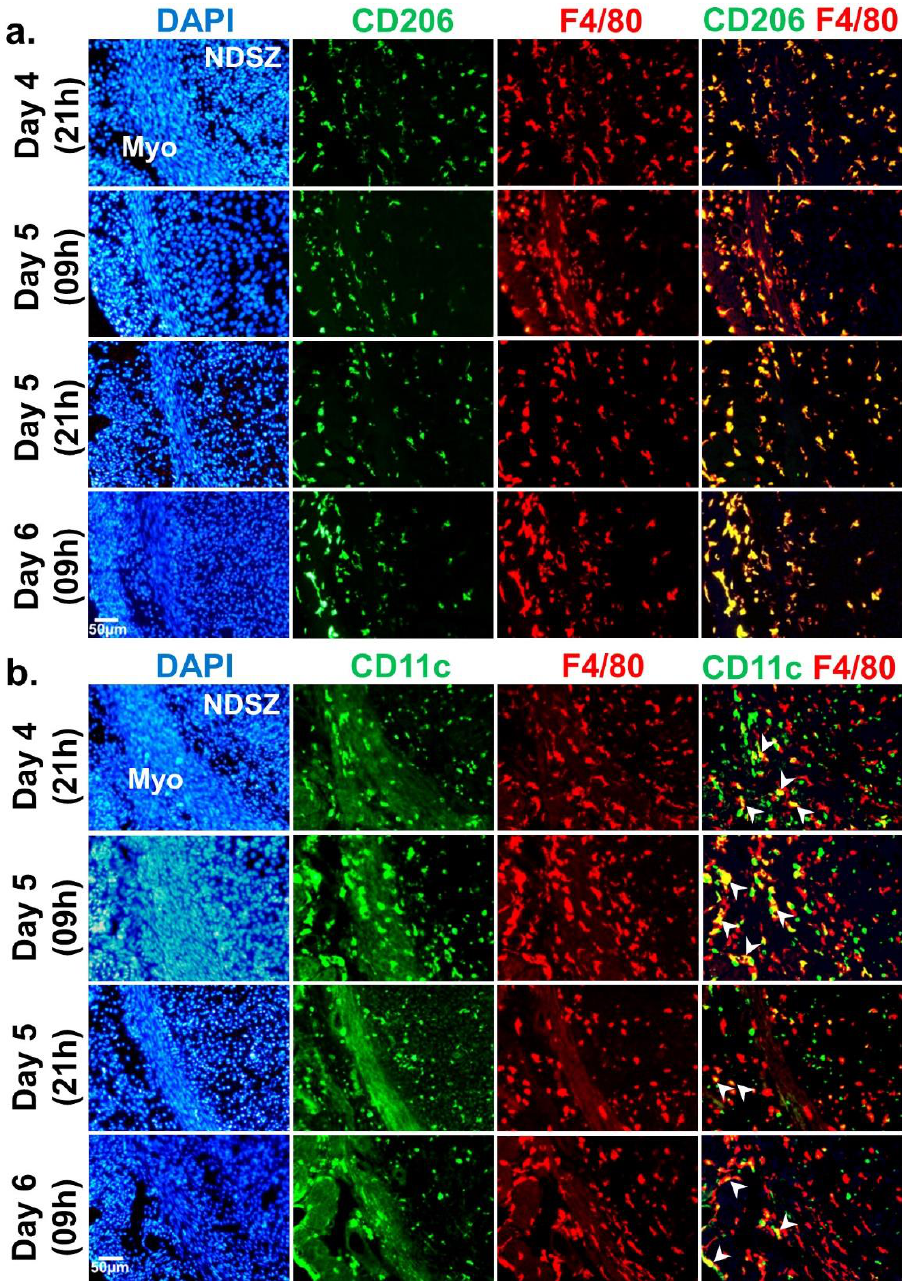
Figure 5. Identification of M1 and M2 MΦs in the uterus during the peri -implantation period (days 4 – 6) of pregnancy. ( a ) Immunofluorescence colocalization analysis of F4/80 (red) and CD206 (green) proteins in the receptive uterus of day 4 (09h) and EBISs of days 5 (09h and 21h) and 6 (09h) of pregnancy. Cross sections obtained from two pieces of uterine tissues/mouse/timepoint of pregnancy were fixed, immunostained, counterstained with DAPI (blue) and photographed. Yellow colored spots designated the colocalization of F4/80 and CD206 proteins. In order to show the tissue structure, overblown DAPI stained images are presented in left-hand column; ( b ) Immunofluorescent double staining was performed using anti-F4/80 (red) and anti-CD11c (green) antibodies. Cross sections obtained from two pieces of uterine tissues/mouse/timepoint of pregnancy were fixed, immunostained with anti- F4/80 and anti-CD11c antibody, counterstained with DAPI (blue) and photographed. Arrowheads designated the colocalization of F4/80 and CD11c proteins. All images were taken from the anti-mesometrial side of the uterus. At least three pregnant mice were used at each timepoint of pregnancy. Myo, myometrium; NDSZ, non-decidualized stromal